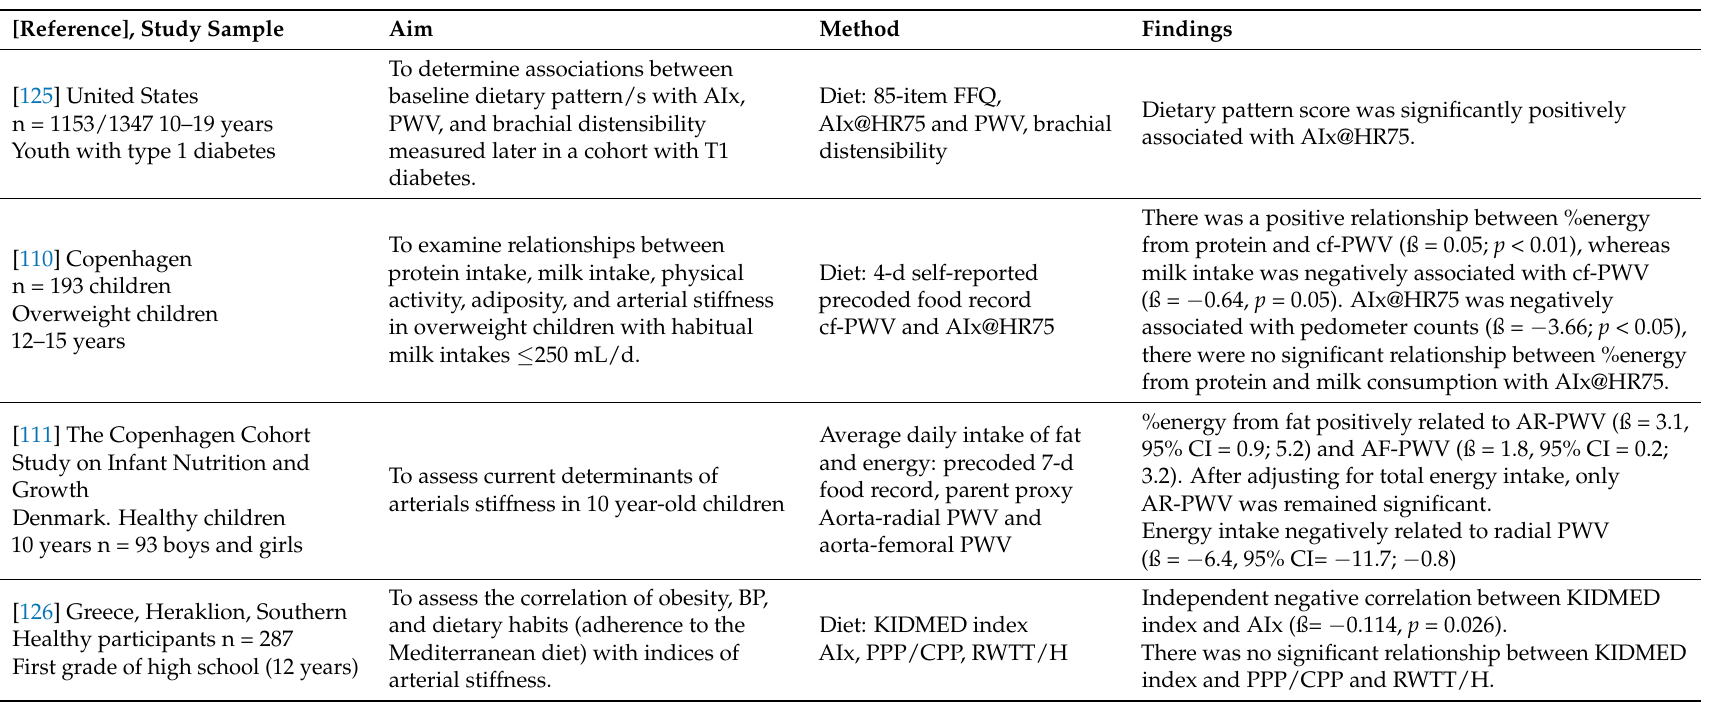
Table 3. Studies on the relationship between dietary intake (nutrients/patterns) and indices of arterial stiffness in children and